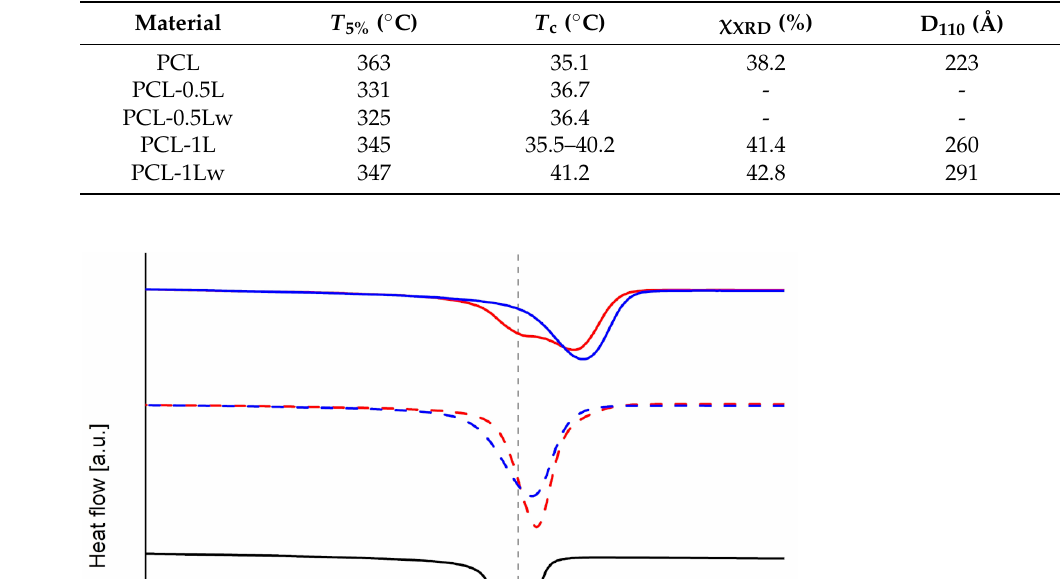
Table 2. Thermal properties of neat and reacted PCL detected by TGA, DSC and XRD analyses. Onset temperatures of degradation ( T 5% ) evaluated at 5% weight losses in TGA. Crystallization temperatures ( T c ) detected from the DSC cooling scans. Crystallinity ( χ XRD ) and crystal size in the direction perpendicular to (110) lattice plane (D 110 ) calculated from XRD diffractograms.